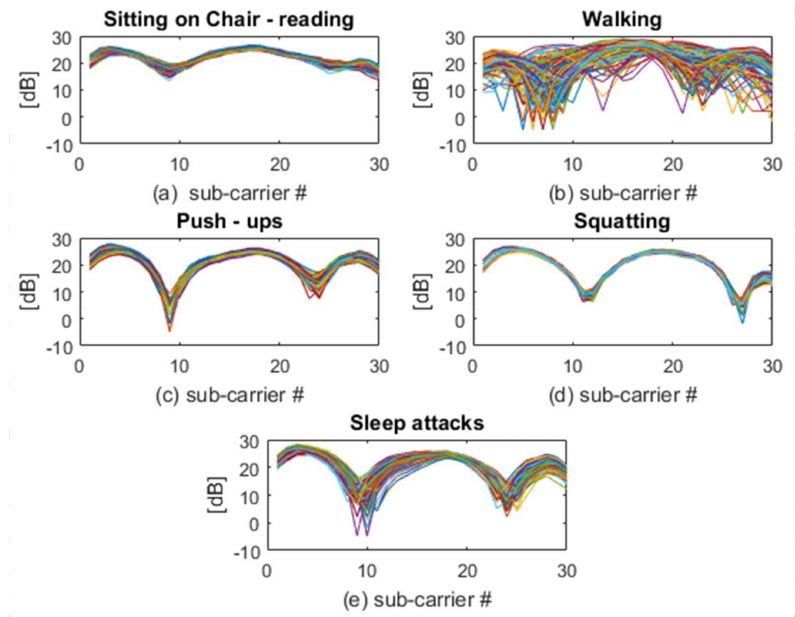
Figure 2. Channel frequency response (CFR) data obtained for five different human activities, different colors in the figures indicate variances of amplitude information of different